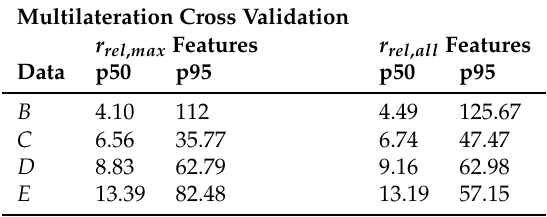
Table 10. The p50 and p95 percentiles of the error expressed in (cm) for the relative multilateration